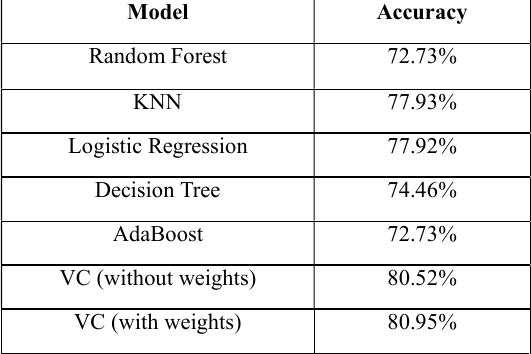
Figure 4: Heart Histogram Attribute Analysis